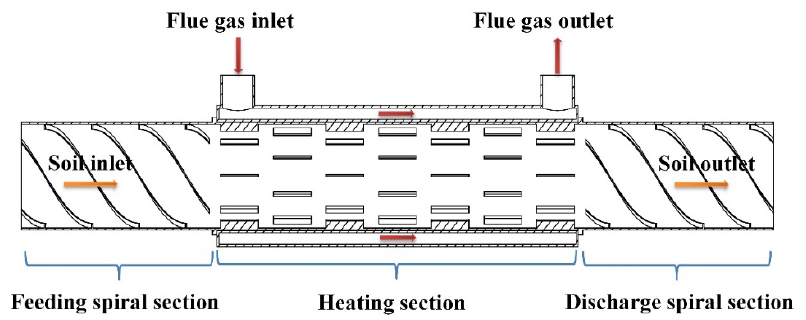
Figure 3. Schematic diagram of internal structure of small rotary dryer.